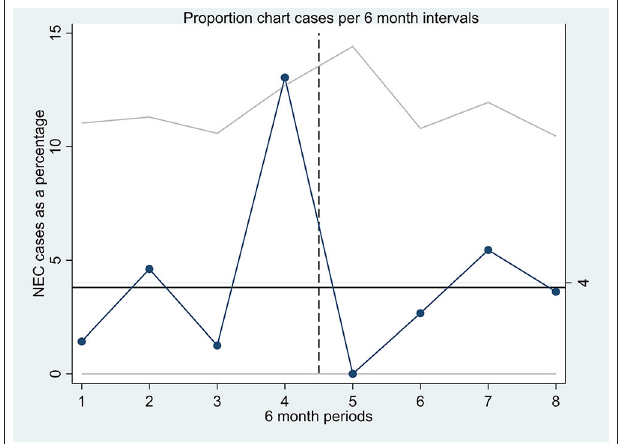
FIGURE 2 | A quality assurance proportion chart (P-chart) with upper confidence interval, each point on the P-chart represents the proportion of NEC cases (in percentage) of all the infants receiving probiotics in each 6-month period of the two epochs.